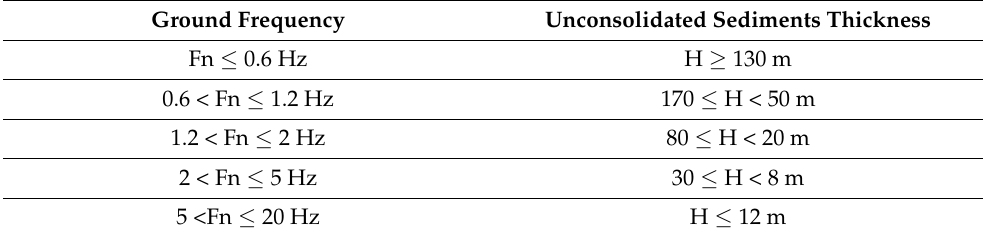
Table 1. Comparison between ground frequency and unconsolidated sediments thickness in the Emilia-Romagna plain (modified from